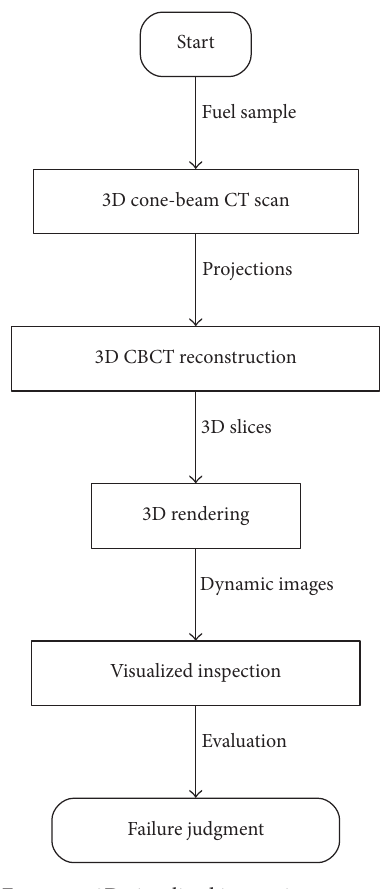
Figure 5: 3D visualized inspection